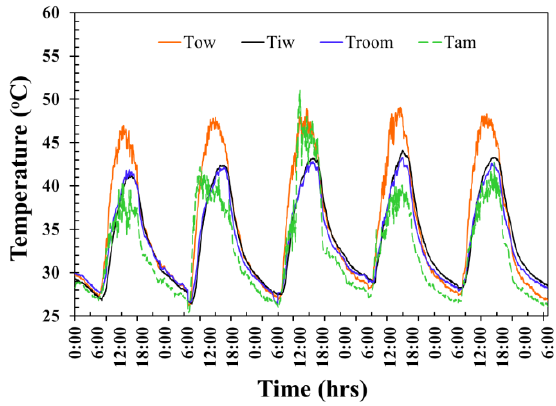
Figure 9. Temperature fluctuation of the AAC-3H testing room wall.